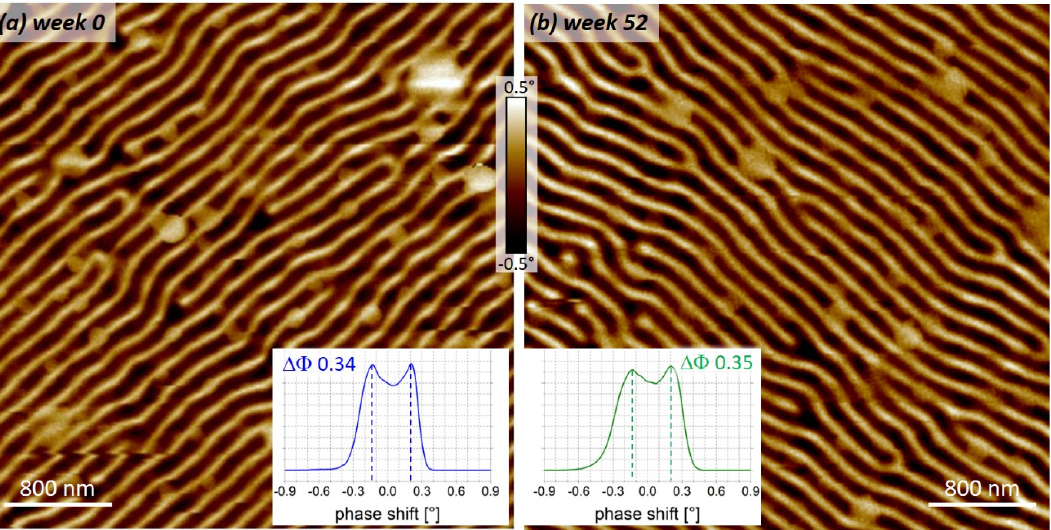
Figure 9. Aging tests for Co 3 Fe α‐ pillars. ( a ) shows an MFM ‐ phase map of CoPt sample after fabri ‐ cation, while ( b ) shows the same nano ‐ probe on the same sample and the same AFM